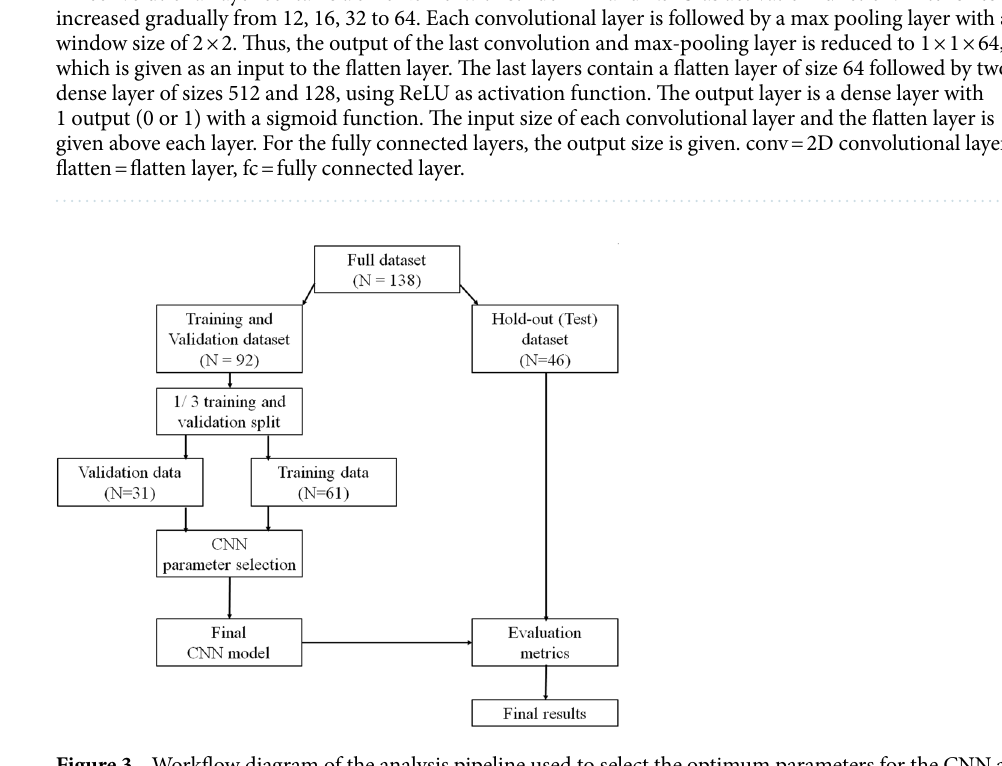
Figure 3. Workflow diagram of the analysis pipeline used to select the optimum parameters for the CNN and to evaluate the performance of the final model. The training, validation and test steps were repeated 100 times for the CNN to evaluate the model